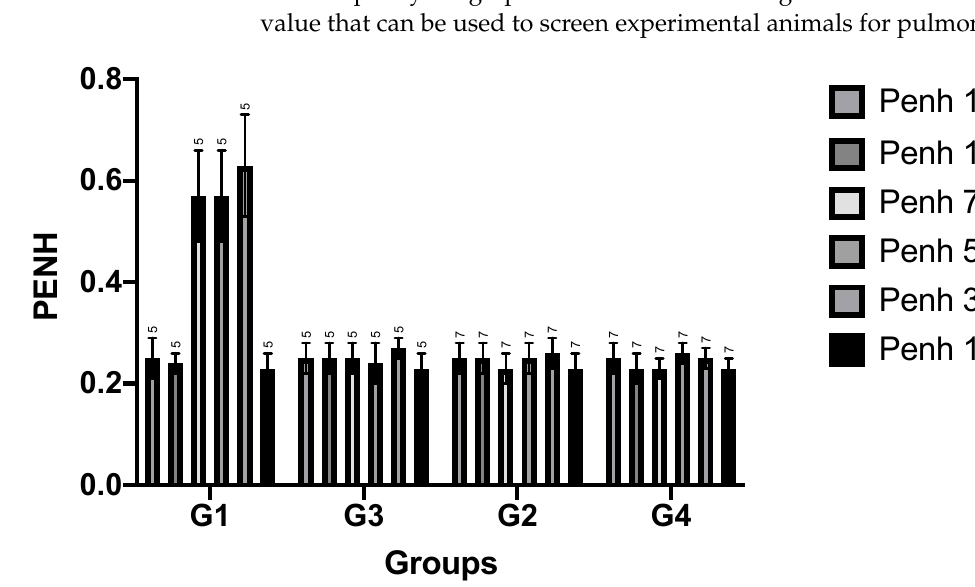
Figure 2. Body weight of the group G2 with a SARS-CoV-2 epi-ocular primary infection then 21